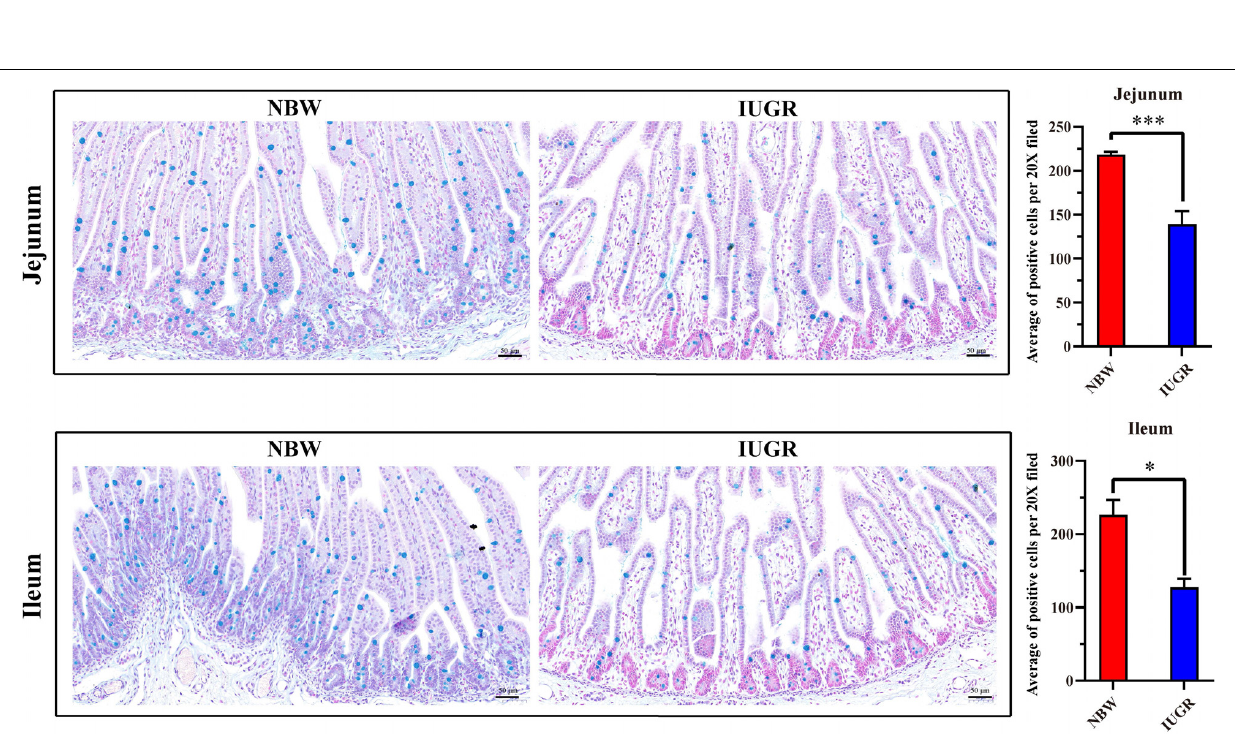
Frontiers in Physiology |